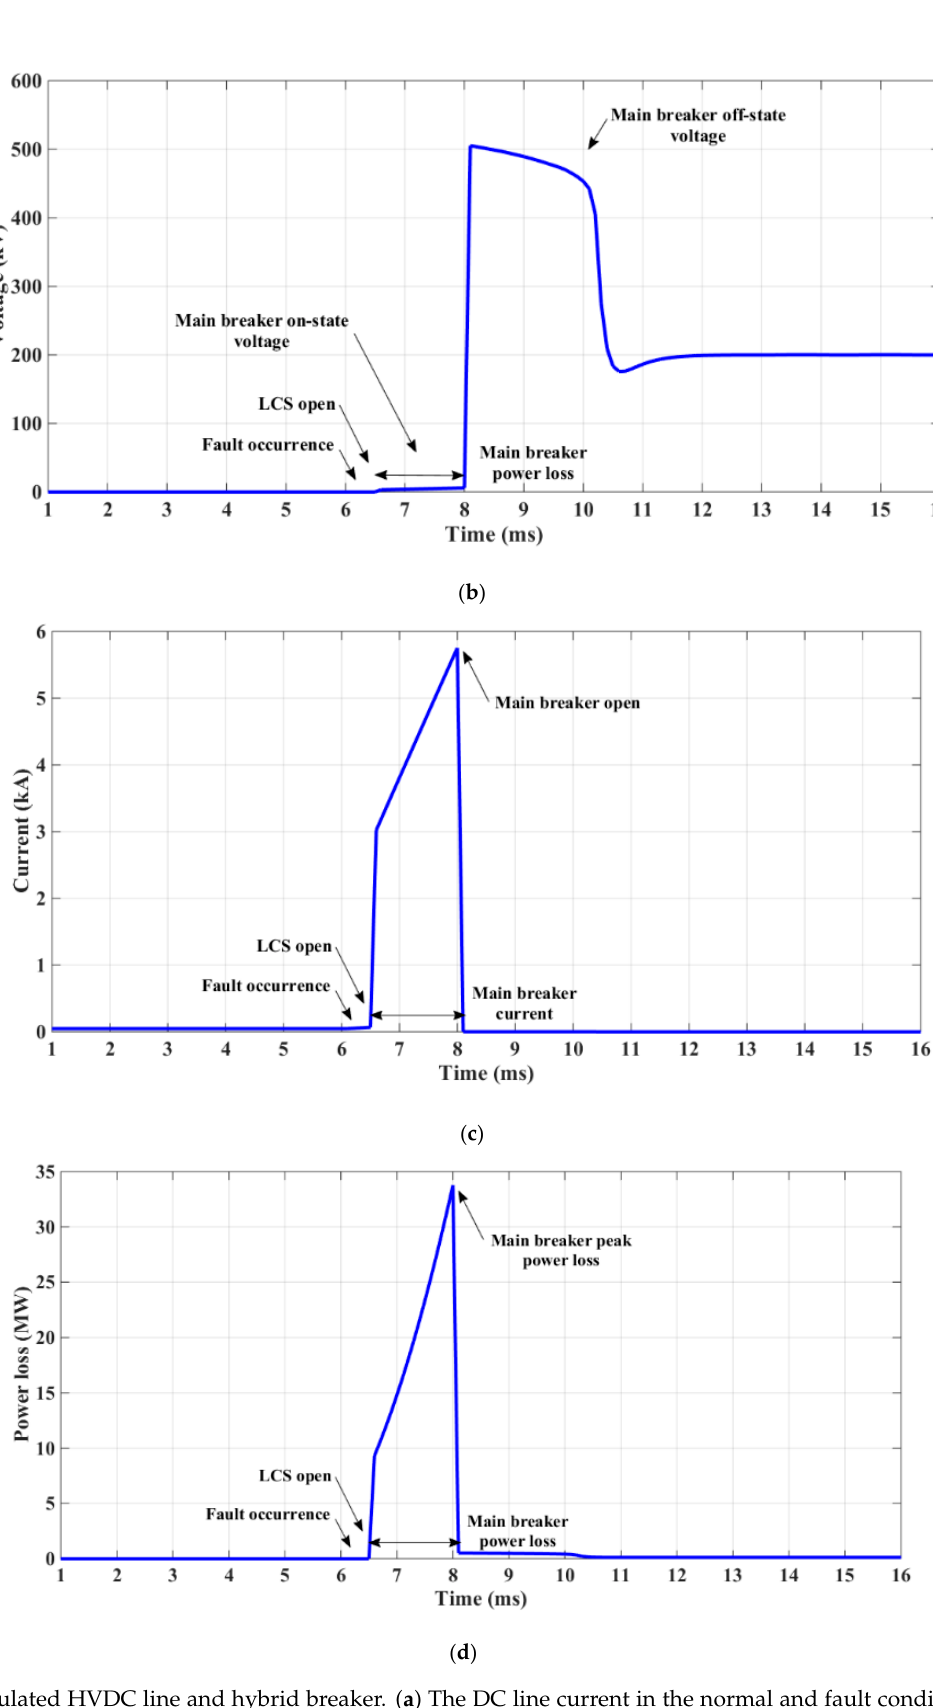
Figure 5. Simulated HVDC line and hybrid breaker. ( a ) The DC line current in the normal and fault condition. ( b ) The hybrid breaker voltage drop in operation mode. ( c ) The main breaker current (hybrid breaker). ( d ) The main breaker power loss (hybrid breaker).